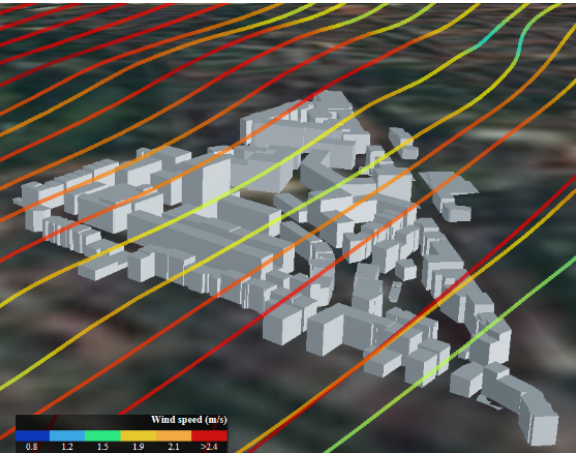
Figure 5. Visualization of the flow lines using